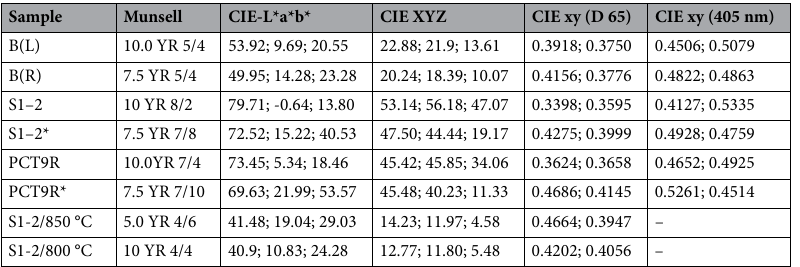
(b* = yellowness hue axis with negative values for blue and positive ones for yellow) could be considered a good indicator of iron oxides in any color, and + a* (a* = redness hue axis with negative values for green and positive ones for red) is a good indicator of iron oxides with a red color. Authors of ref. 34 found that calcium carbonate enhances soil lightness L* (L* = 0 and L* = 100 correspond to no reflection of black and perfect reflection for white, respectively). When applying these results to data from ref. 35 on pure hematite red powders synthesized at 600 °C, a* and b* values are positive and relatively high, as expected a* = 35.4–38.7, b* = 38.6–42.4, while L* = 40.6–43.5, i.e. L* takes intermediate values (average particle size 375–475 nm by SEM). For the pure hema- tite powders synthesized at 300 °C departing from red to orange (dull orange or light brownish) the parameters are a* = 5.6–8.5, b* = 12.1–18.4, and L* = 36.4–51.8 (average particle size 1500–4260 nm). When annealing is